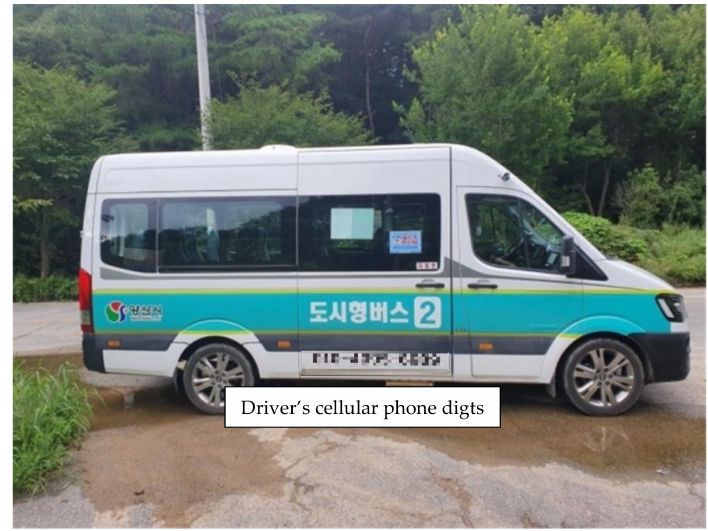
Figure 7. City-type bus in Korea (Yangsan city-type bus No. 2)